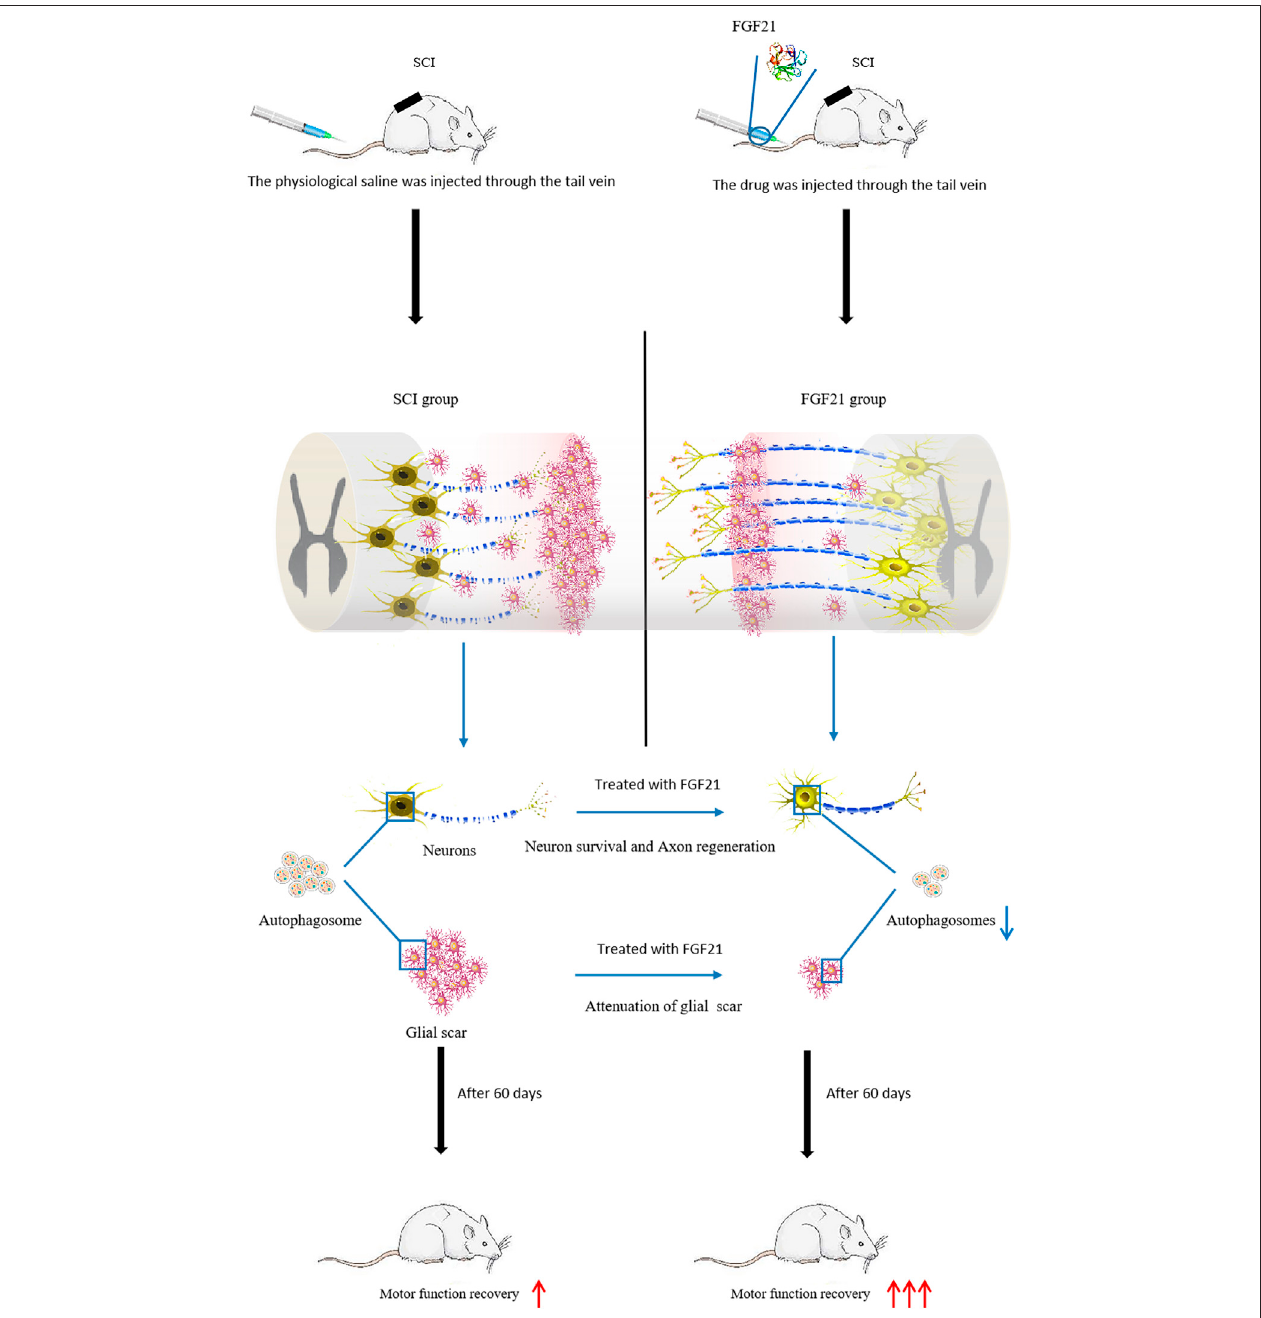
FIGURE 7 | Injection of FGF21 inhibits autophagy and promotes motor function recovery.